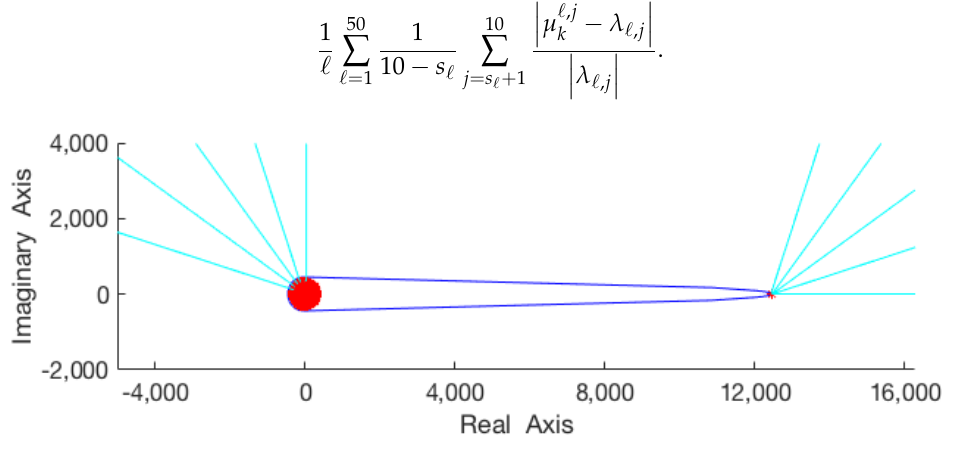
Figure 3. Indicative numerical range of 500 × 500 non–negative matrix and 10 approximating trajectories. Table 1. Relative approximation errors for Perron root and other peripheral eigenvalues of 500 × 500 non–negative matrices. # of Mean Rel. Error Mean Rel.